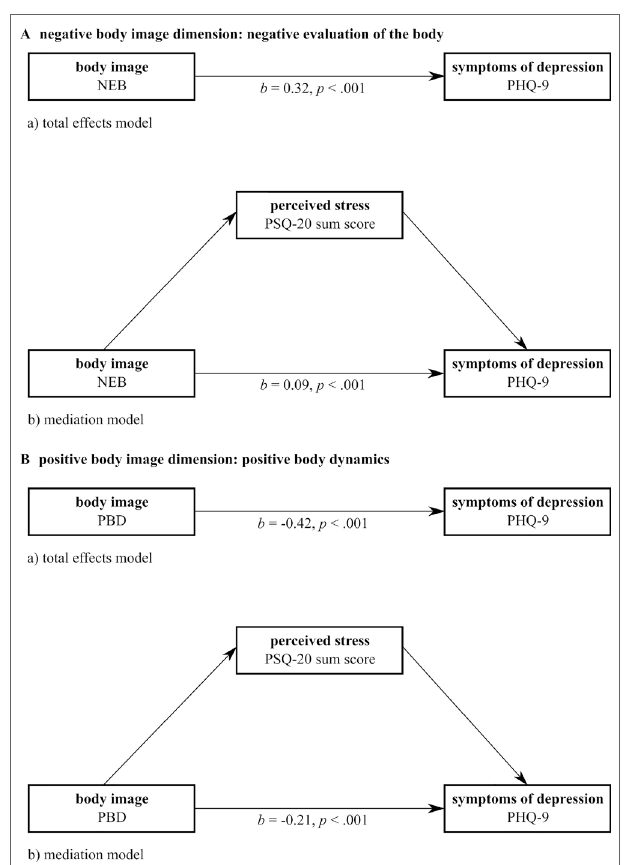
FIgURe 1 | Graphical illustration of the mediation analyses. NEB, negative evaluation of the body; PBD, positive body dynamics; PHQ-9, Patient Health Questionnaire (section depression); PSQ-20, Perceived Stress